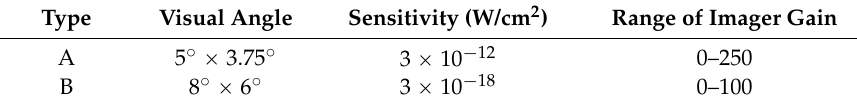
Figure 4. PTU2000.